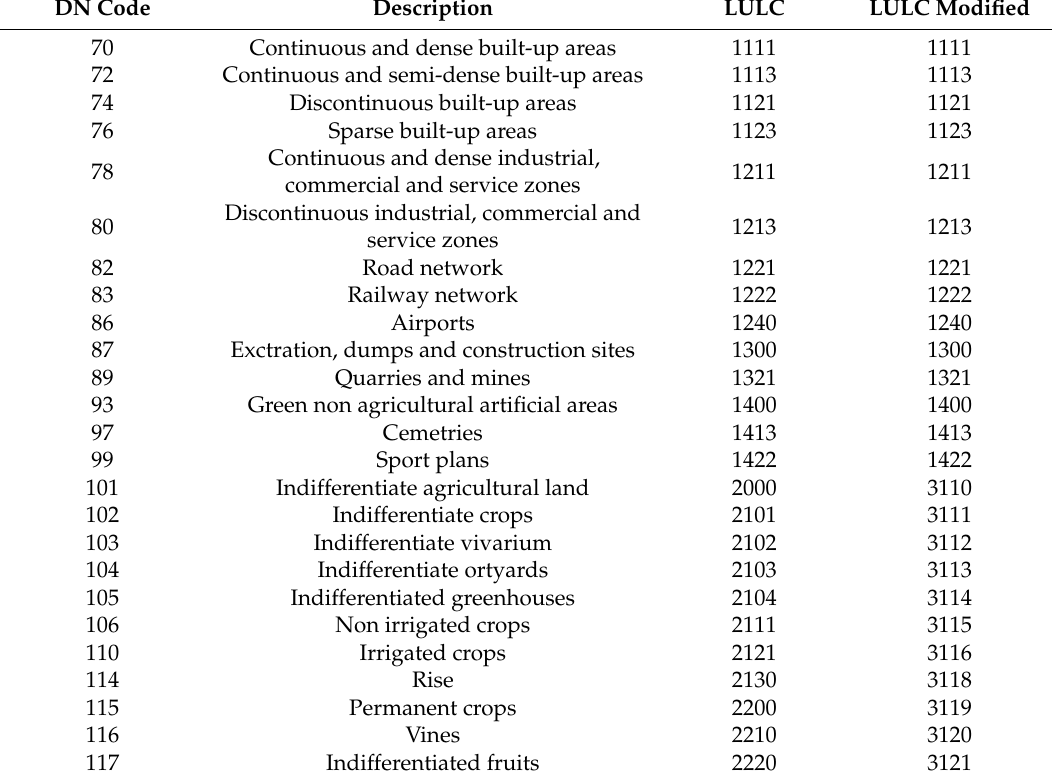
Table A2. Validation of the model changing LULC code